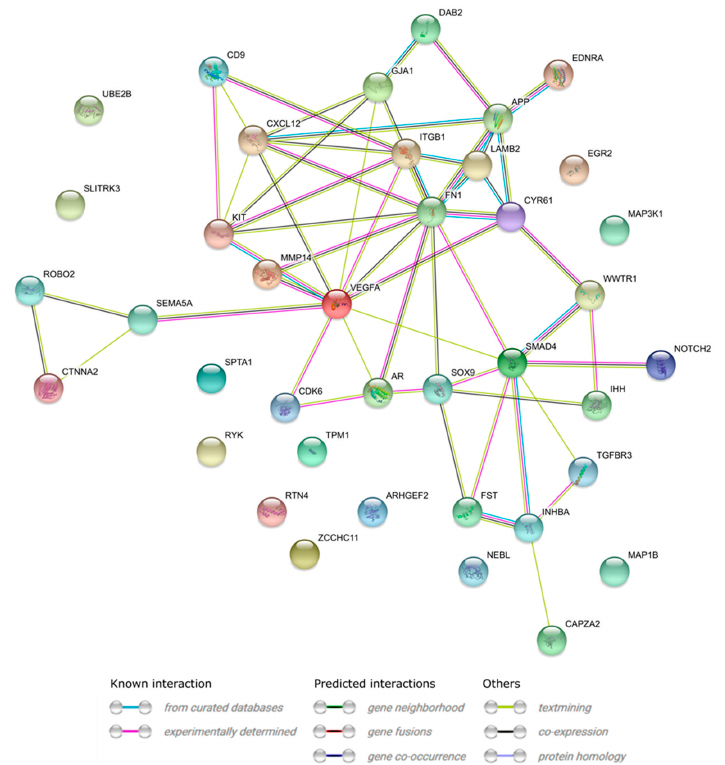
Figure 8. STRING-generated interaction network between genes that belong to the “cellular component morphogenesis”, “negative regulation of cell differentiation”, “morphogenesis of a branching structure”, “regulation of cellular component size”, and “branching morphogenesis of a tube” GO BP terms. The intensity of the edges reflects the strength of interaction score. Genes 2020 , 11 , x FOR PEER REVIEW